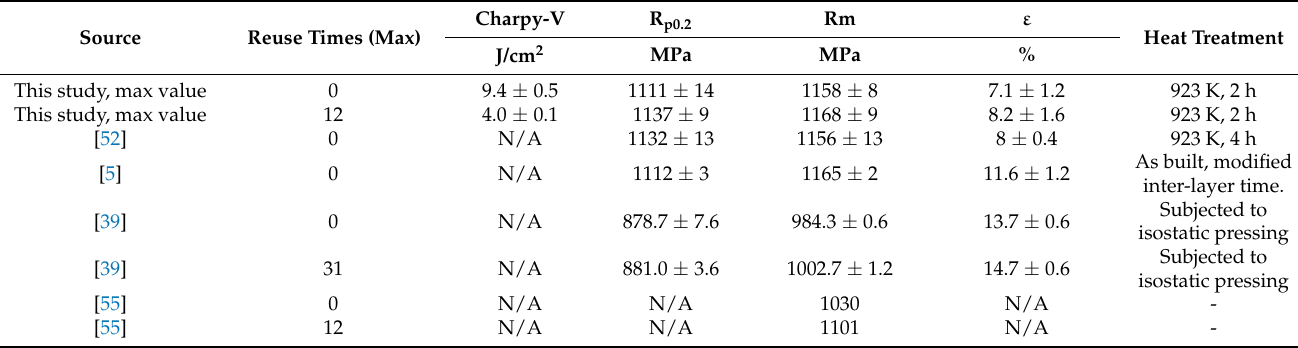
Table 3. Comparison of mechanical properties with the state of the art. Sample printing orientation: vertical in respect to the horizontal powder